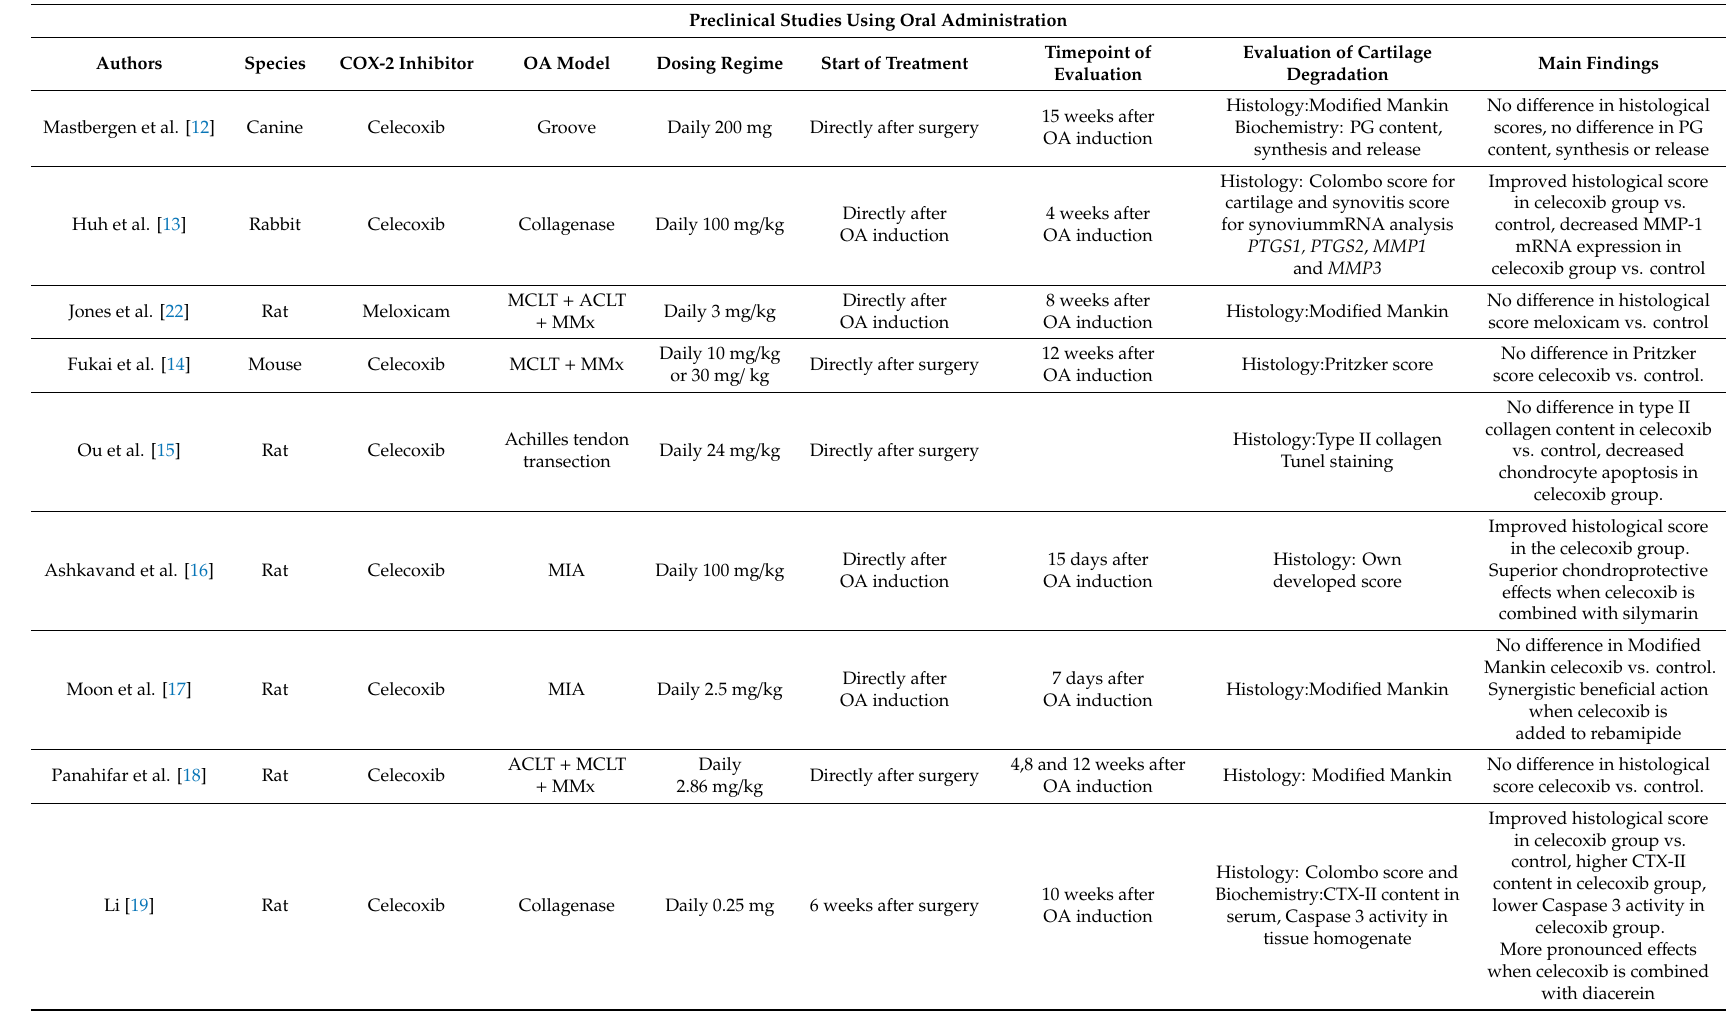
Table 1. The schematic of studies investigating chondroprotective e ff ects of systemically administered selective COX-2